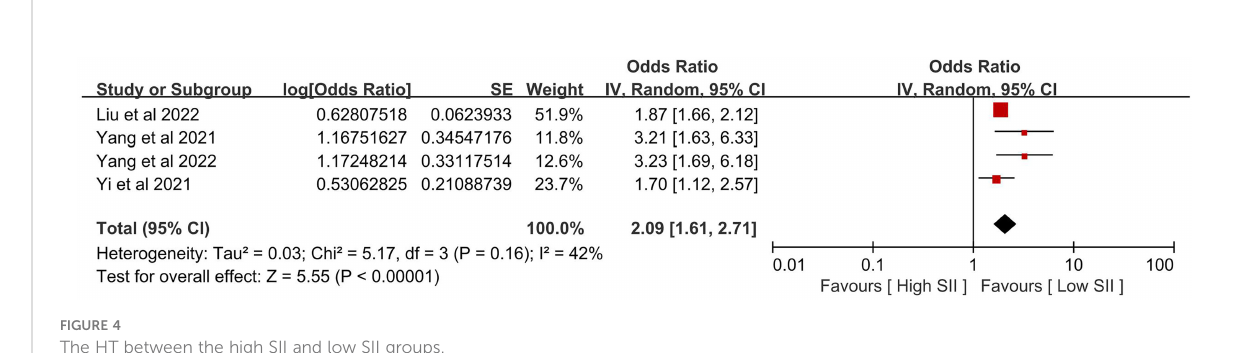
FIGURE 4 The HT between the high SII and low SII groups.